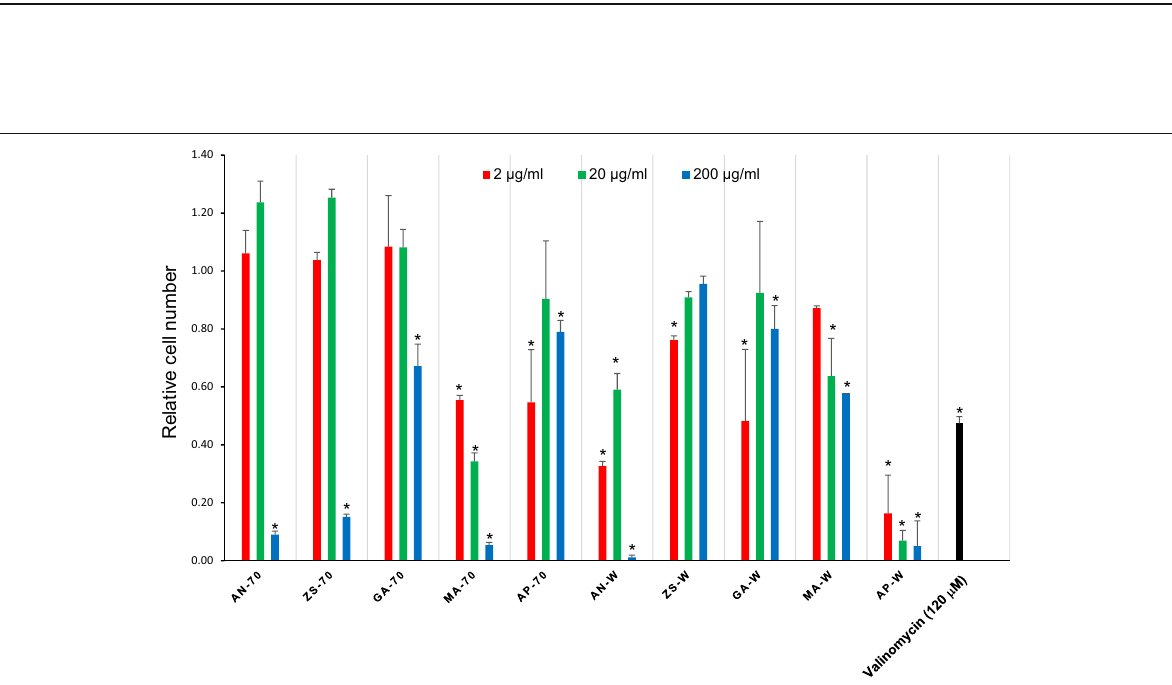
Fig. 2 Imaging of cytotoxicity of Sudanese medicinal plants in HeLa cells using the HCS DNA Damage Kit. AN: Acacia nilotica , ZS: Ziziphus spina-christi , GA: Geigeria alata. MA: Martynia annua AP: Abrus precatorius ; For each extract, 70 represents 70% EtOH extract and W represents water extract. As a control experiment, HeLa cells were treated with 120 μ M valinomycin for 24 h at 37 °C/5% CO 2 . Imaging and analysis were performed using a BZ-X700. At 120 μ M valinomycin, cells showed cytotoxic effects as demonstrated by the positive Image-iT® DEAD Green ™ viability stain